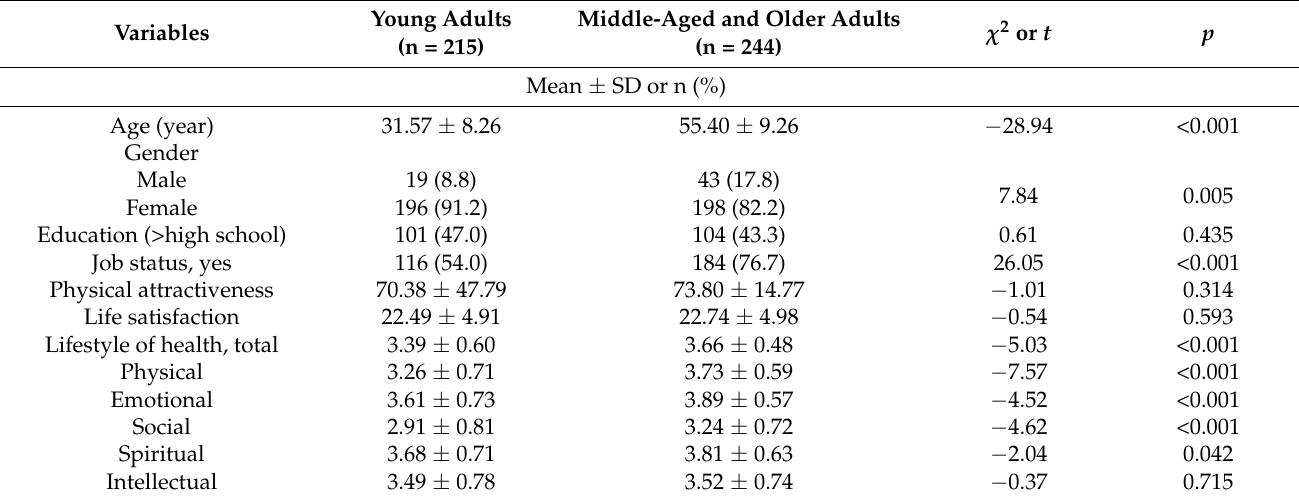
Table 1. General participant characteristics (N =